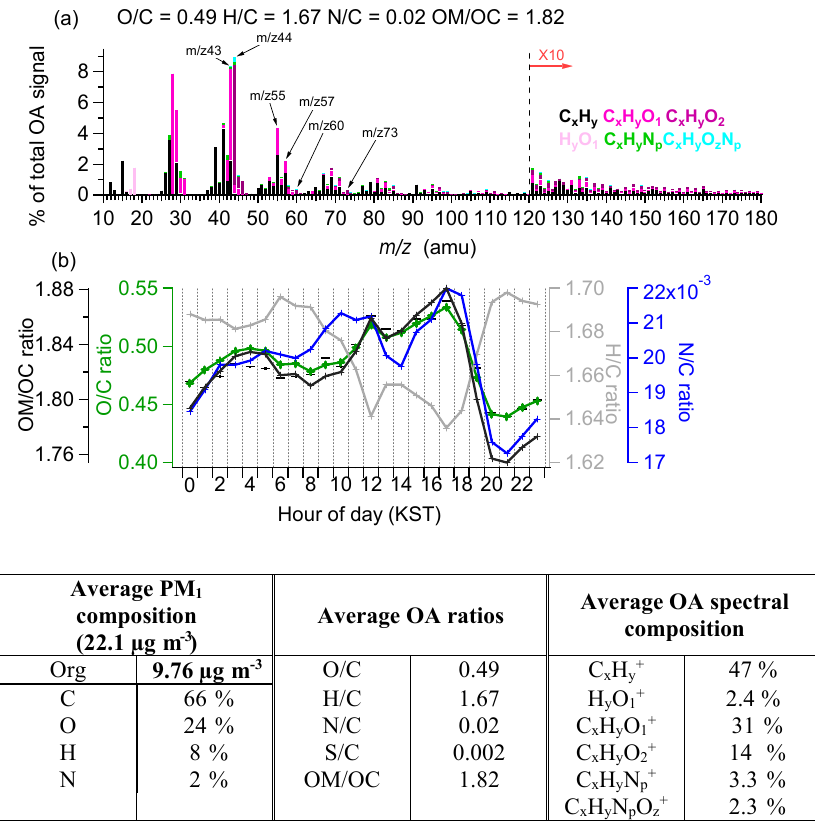
Figure 7. (a) Average high-resolution mass spectrum of OA colored by the different ion families. The average elemental ratios for the OA fraction are described; (b) average diurnal profiles of the organic matter to organic carbon (OM / OC), oxygen to carbon (O / C), hydrogen to carbon (H / C), and nitrogen to carbon (N / C), where the O / C, H / C and OM / OC elemental ratios were determined using the updated method (Canagaratna et al., 2015). The table shown is the overview of the OA compositions in SMA during KORUS-AQ.